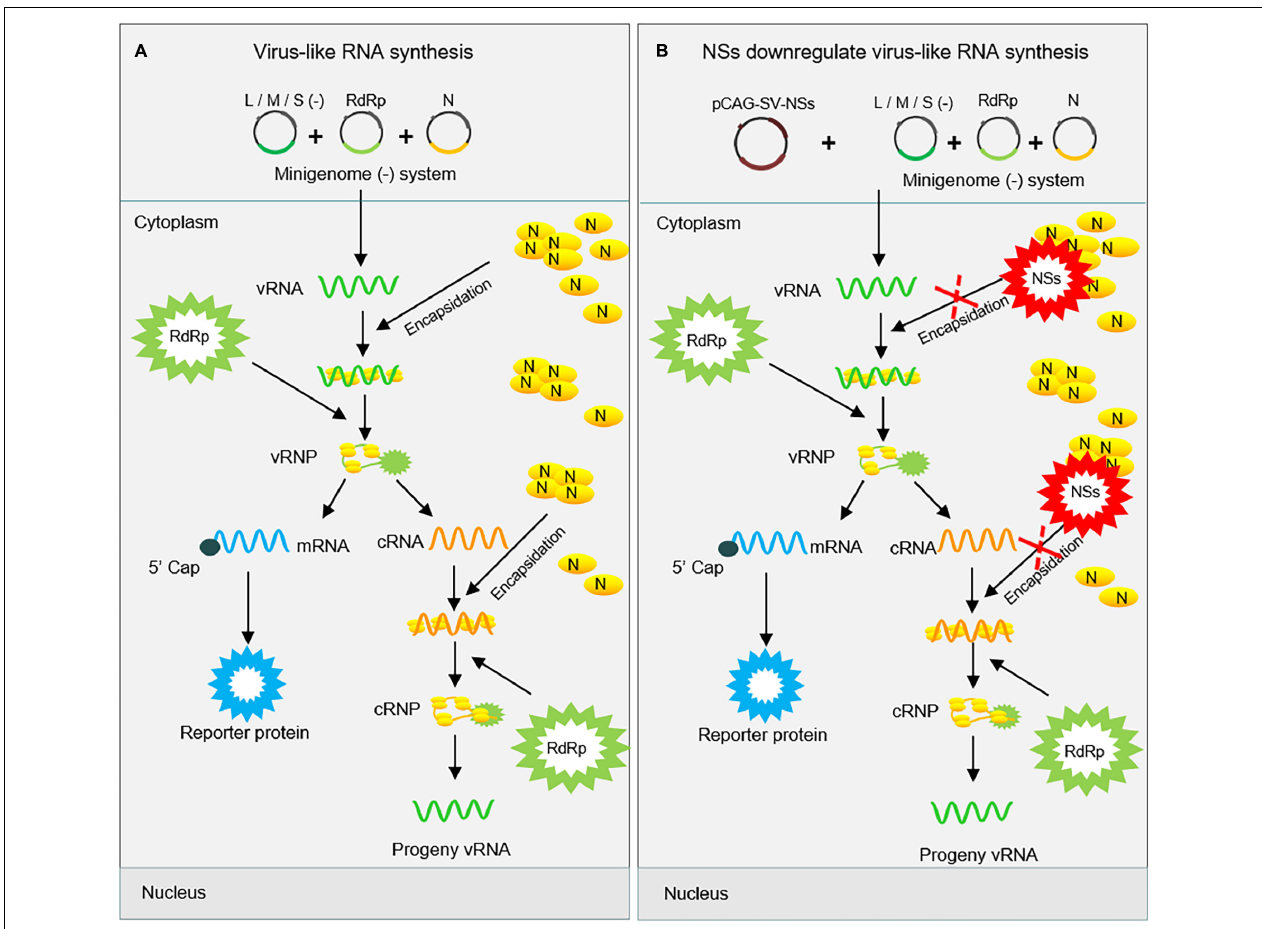
FIGURE 8 | Proposed mechanism for the downregulation of virus-like RNA synthesis by SFTSV NSs within the minigenome reporter system. SFTSV NSs inhibit virus-like RNA synthesis by blocking the N–RNA interaction through sequestering N into inclusion bodies within minigenome reporter systems. As shown in (A) , initial genome virus-like RNA (vRNA) is generated by pol I transcription using cDNA as templates. After encapsidation by N, the coated nascent vRNA can assemble with RdRp to form vRNP. Then, mRNA and progeny cRNA and vRNA are generated by transcription and replication, respectively. However, overexpressed NSs block the encapsidation of viral RNAs by competing with nascent RNA to interact with N (B) . This, downregulates the synthesis of viral RNA, thus leading to decreased levels of the reporter